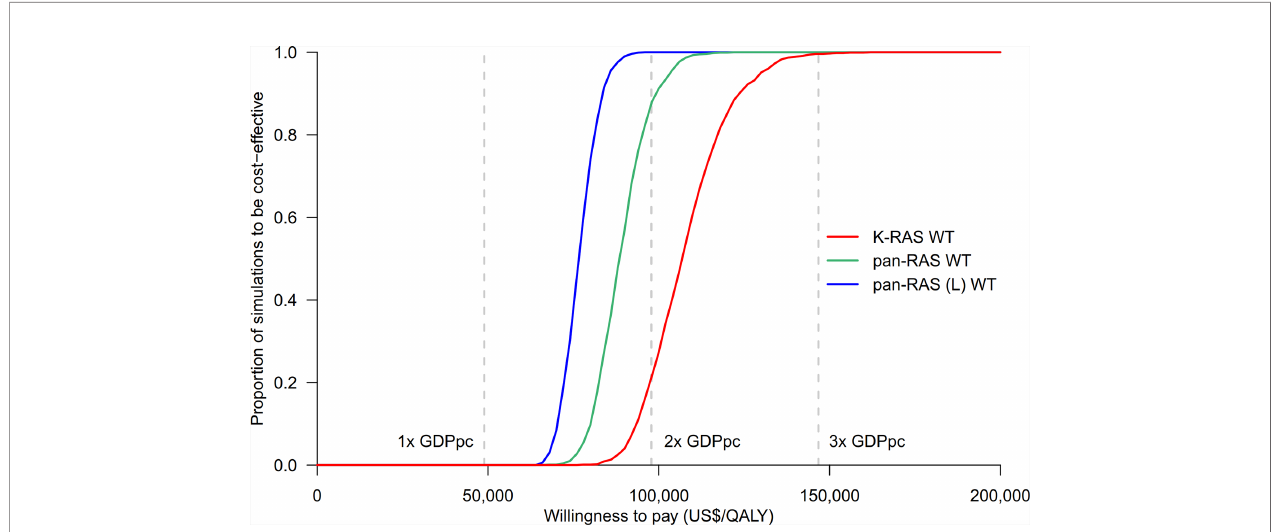
FIGURE 2 | Cost-effectiveness acceptability curves of chemotherapy + anti-EGFR mAb vs. chemotherapy + bevacizumab in KRAS WT, pan-RAS WT, and pan-RAS WT left-sided colonic tumor. anti-EGFR mAb, anti-epidermal growth factor receptor monoclonal antibody; GDPpc, gross domestic product per capita; QALY, quality- adjusted life years; pan-RAS (L) WT, pan-RAS wild-type left-sided colonic tumor; WT,